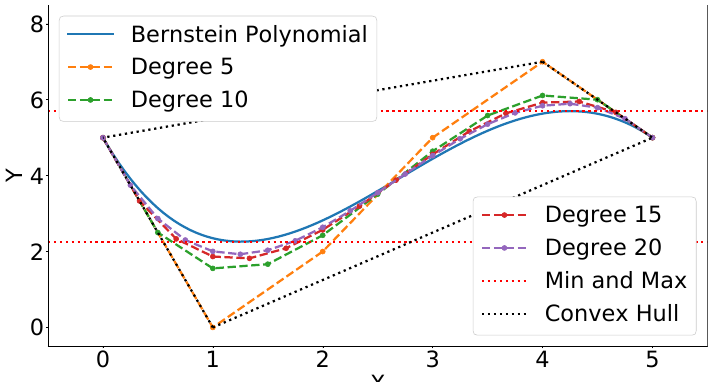
Figure 18. Bounds for Bernstein polynomials. The solid blue line is the Bernstein polynomial, the dashed lines connect the coefficients of each different order, the black dotted line represents the convex hull of the 5th degree Bernstein polynomial, and the red dotted lines represent the actual